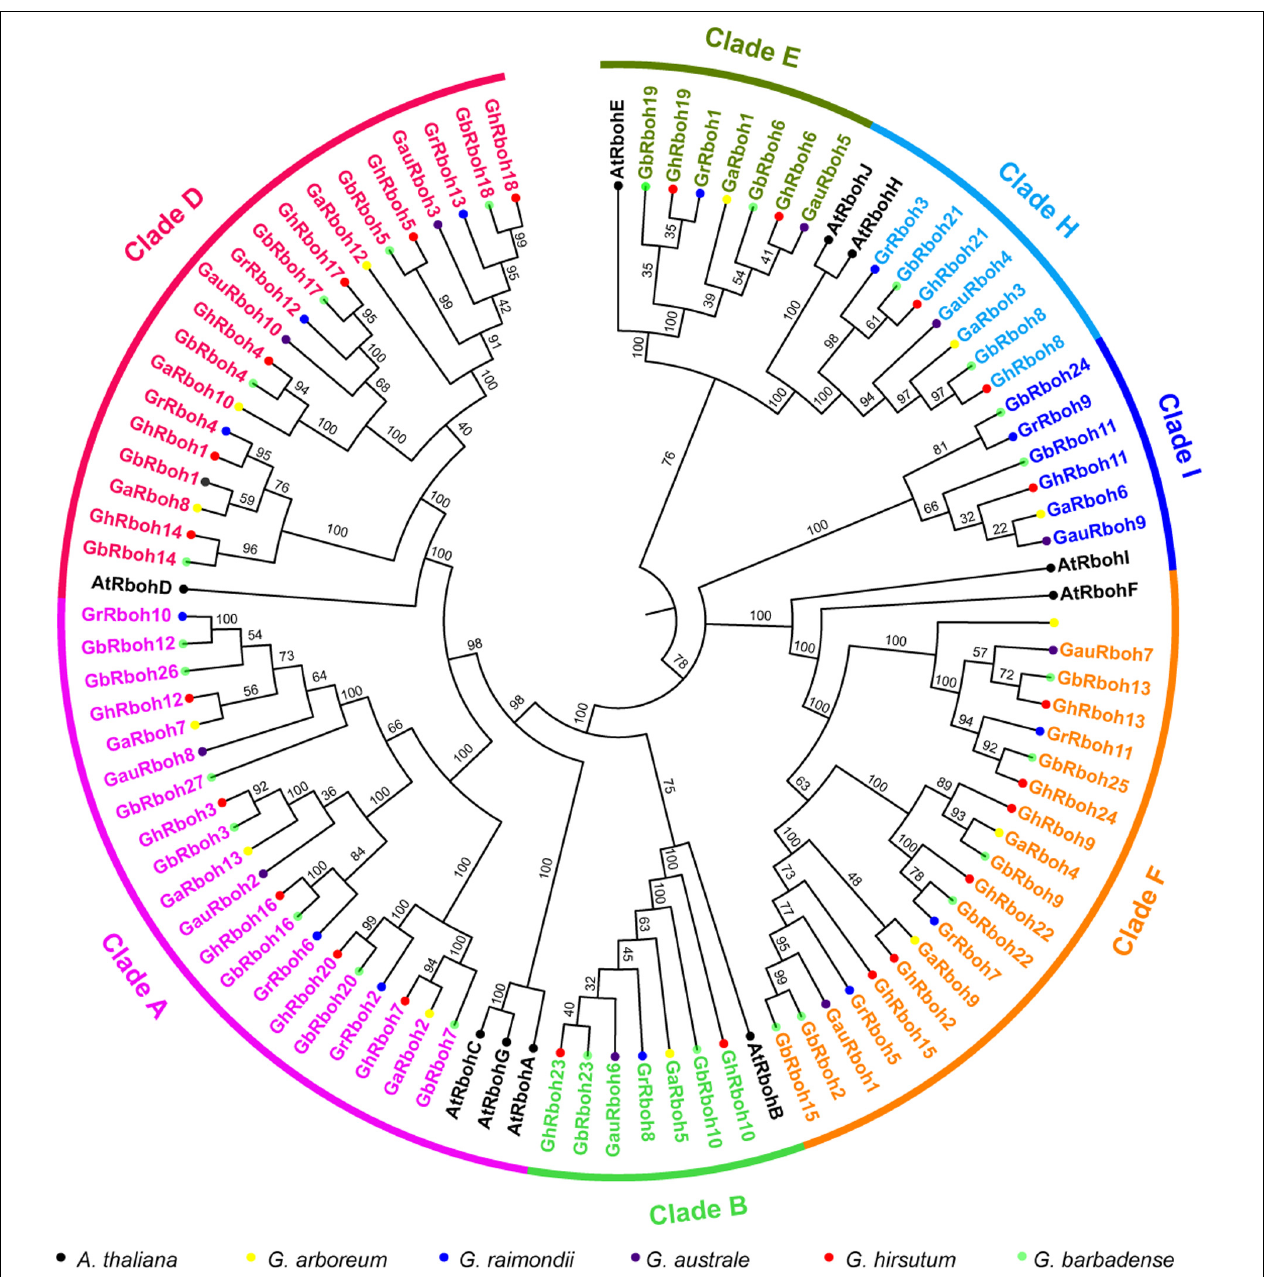
FIGURE 1 | Phylogenetic analysis of Rbohs in cotton and Arabidopsis. A phylogenetic tree of Rboh proteins from G. arboreum , G. raimondii , G. australe , G. hirsutum , G. barbadense, and A . thaliana . The full-length amino acid sequences of the Rboh proteins were aligned using ClustalX in MEGA7.0. The unrooted tree was generated by the neighbor-joining (NJ) method ( n = 1000 bootstraps). Clades are distinguished by different colors. Cotton Rbohs are colored clade specifically and the Arabidopsis Rbohs are in black. Different-colored solid circles indicate genes in different Gossypium species or Arabidopsis.